Question: In one sentence, what is this figure communicating?
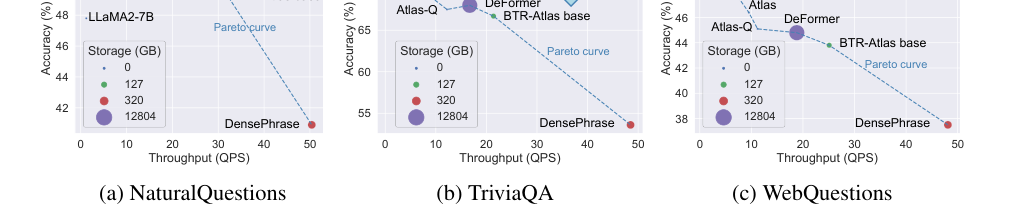
Answer: Task performance and inference efficiency (throughput and storage) visualization across the baselines and BTR fine-tuned models on three open-domain QA datasets. The area of the circle denotes storage size (we scale the area size of BTR-base and DensePhrase by 10 for clear display). A top-right smaller circle is better.